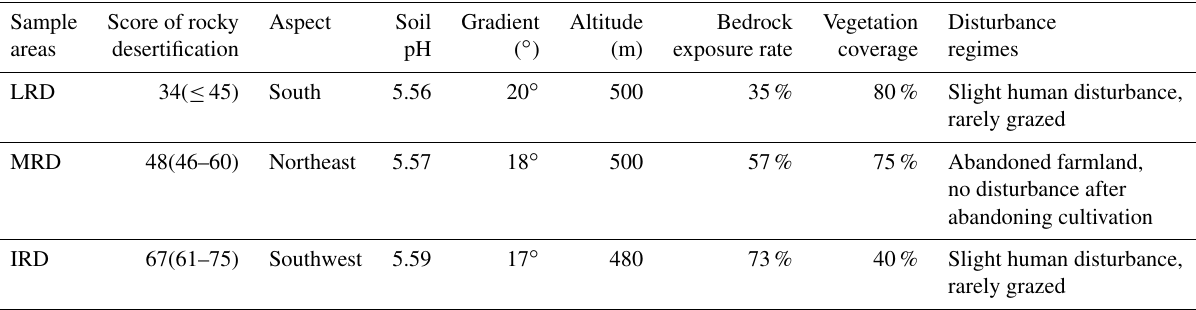
Table 1. Basic description for different grades of rocky desertification